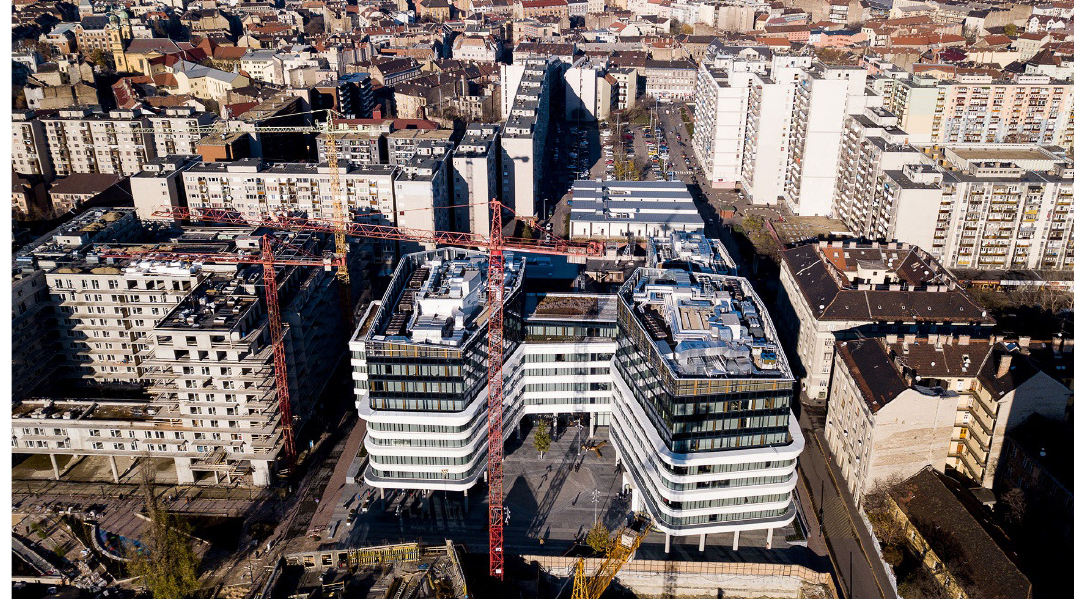
Figure 9. A public webcam took photos during the construction of a large‐scale office building at the end of the Corvin Promenade and Szigony